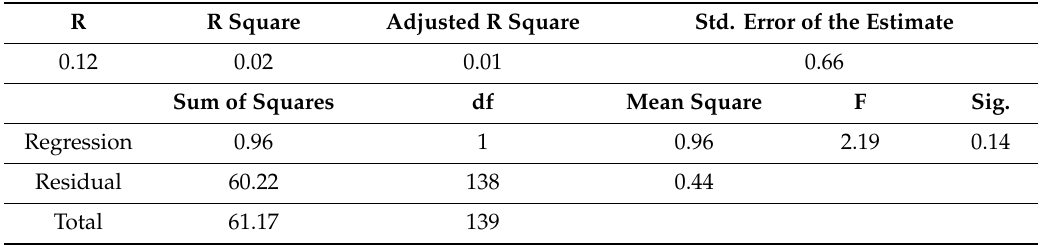
Table 10. Model Summary (Community Planning Potential), ANOVA (Community planning Potential). R R Square Adjusted R Square Std. Error of the